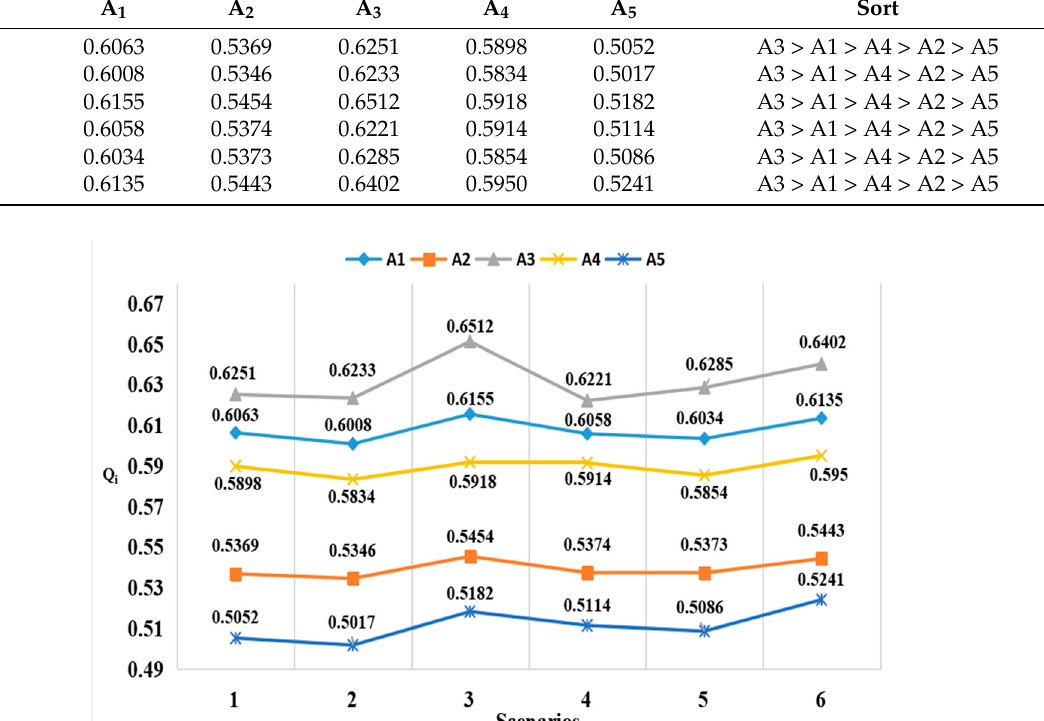
Table 11. Sensitivity rankings of